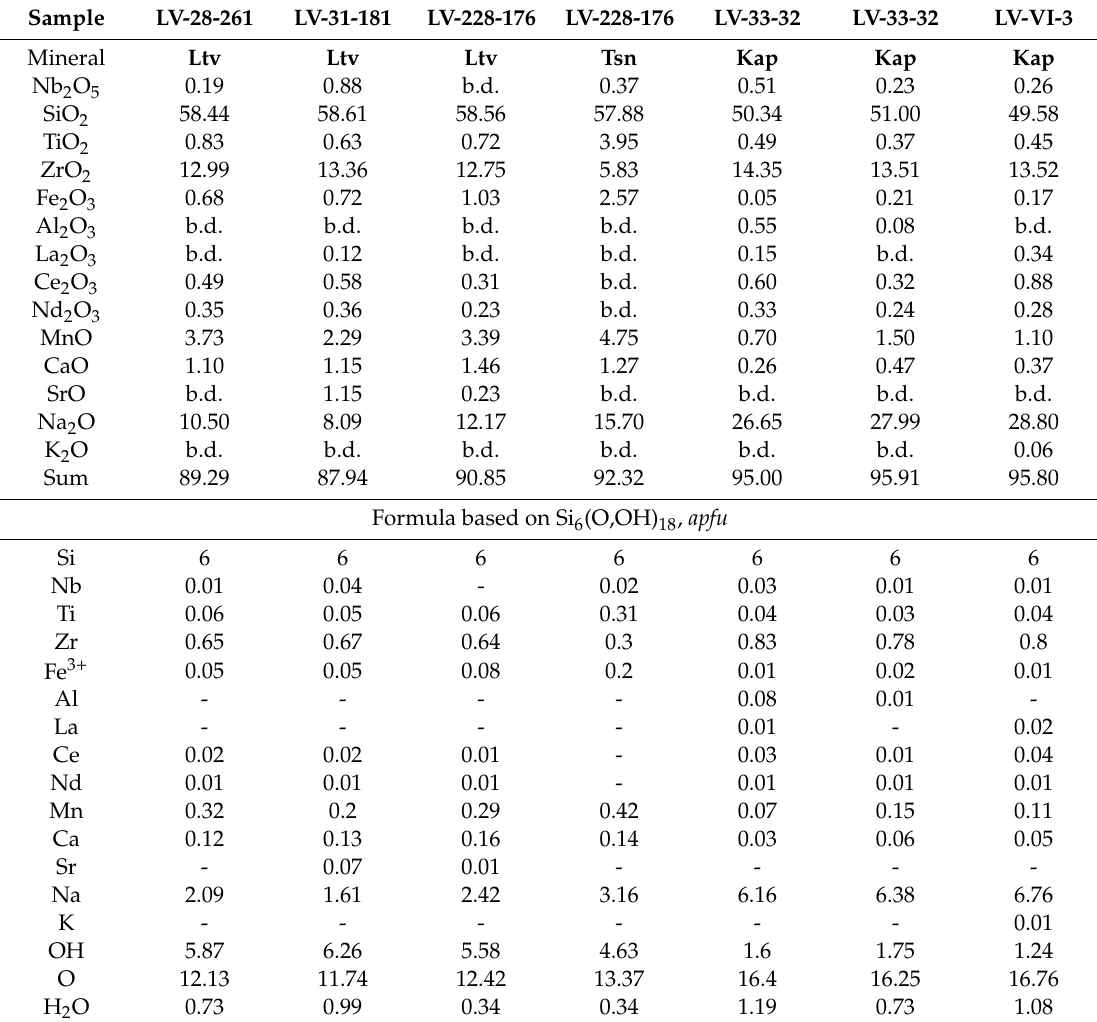
Table 5. Representative microprobe analyses of the lovozerite-group minerals, wt.%. Sample